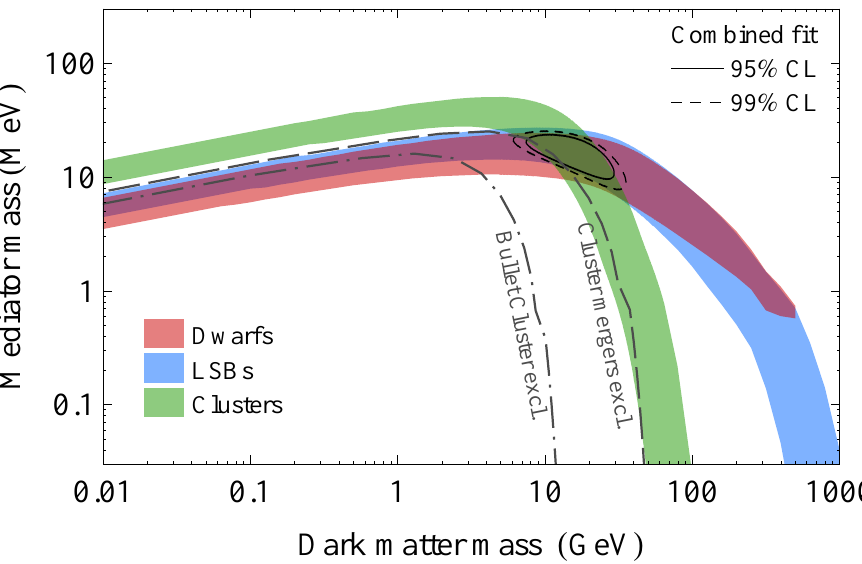
Figure 20. Parameter space spanning the mass m χ of the SIDM particle and the vector mediator mass m φ with self-coupling α χ = α = 1/137. Regions preferred by dwarfs (red), LSB spiral galaxies (blue) and galaxy clusters (green), each at 95% confidence level, are indicated. Combined 95% (99%) region is shown by the solid (dashed) contour. The region estimated to be excluded by the Bullet Cluster (other observed merging clusters) lies below the dot-dashed (long-dashed) curve. The figure is reproduced from